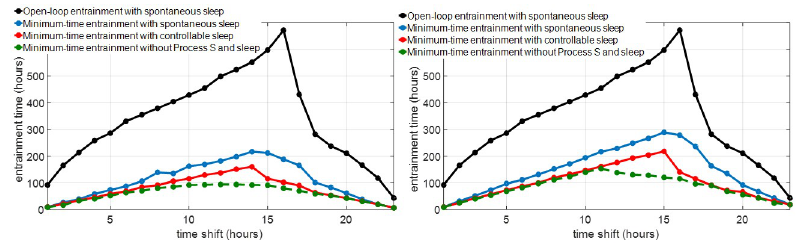
Fig 4. Entrainment time comparison of different entrainment strategies with I max = 10000 lux (left), I max = 1000 lux (right) and different time shifts Δ shift . The black curve shows the open-loop entrainment time with spontaneous sleep; the blue curve shows the minimum entrainment time with spontaneous sleep; the red curve shows the minimum entrainment time with controllable sleep; the green dash line shows the minimum entrainment time of circadian rhythm without Process S and sleep, solved by the method in